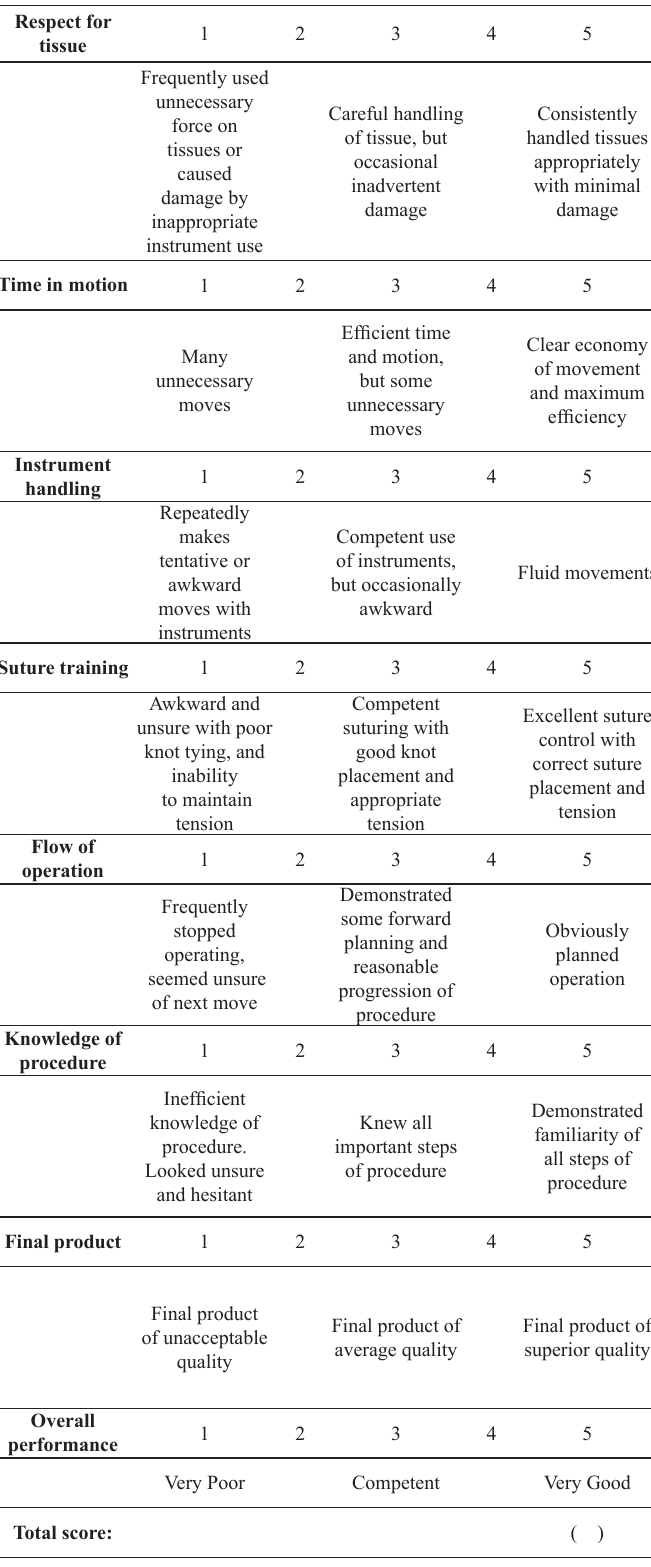
TABLE 1 – Global Rating Scale 13,14 used for the objective assessment of suture performances of students in the pre and post-